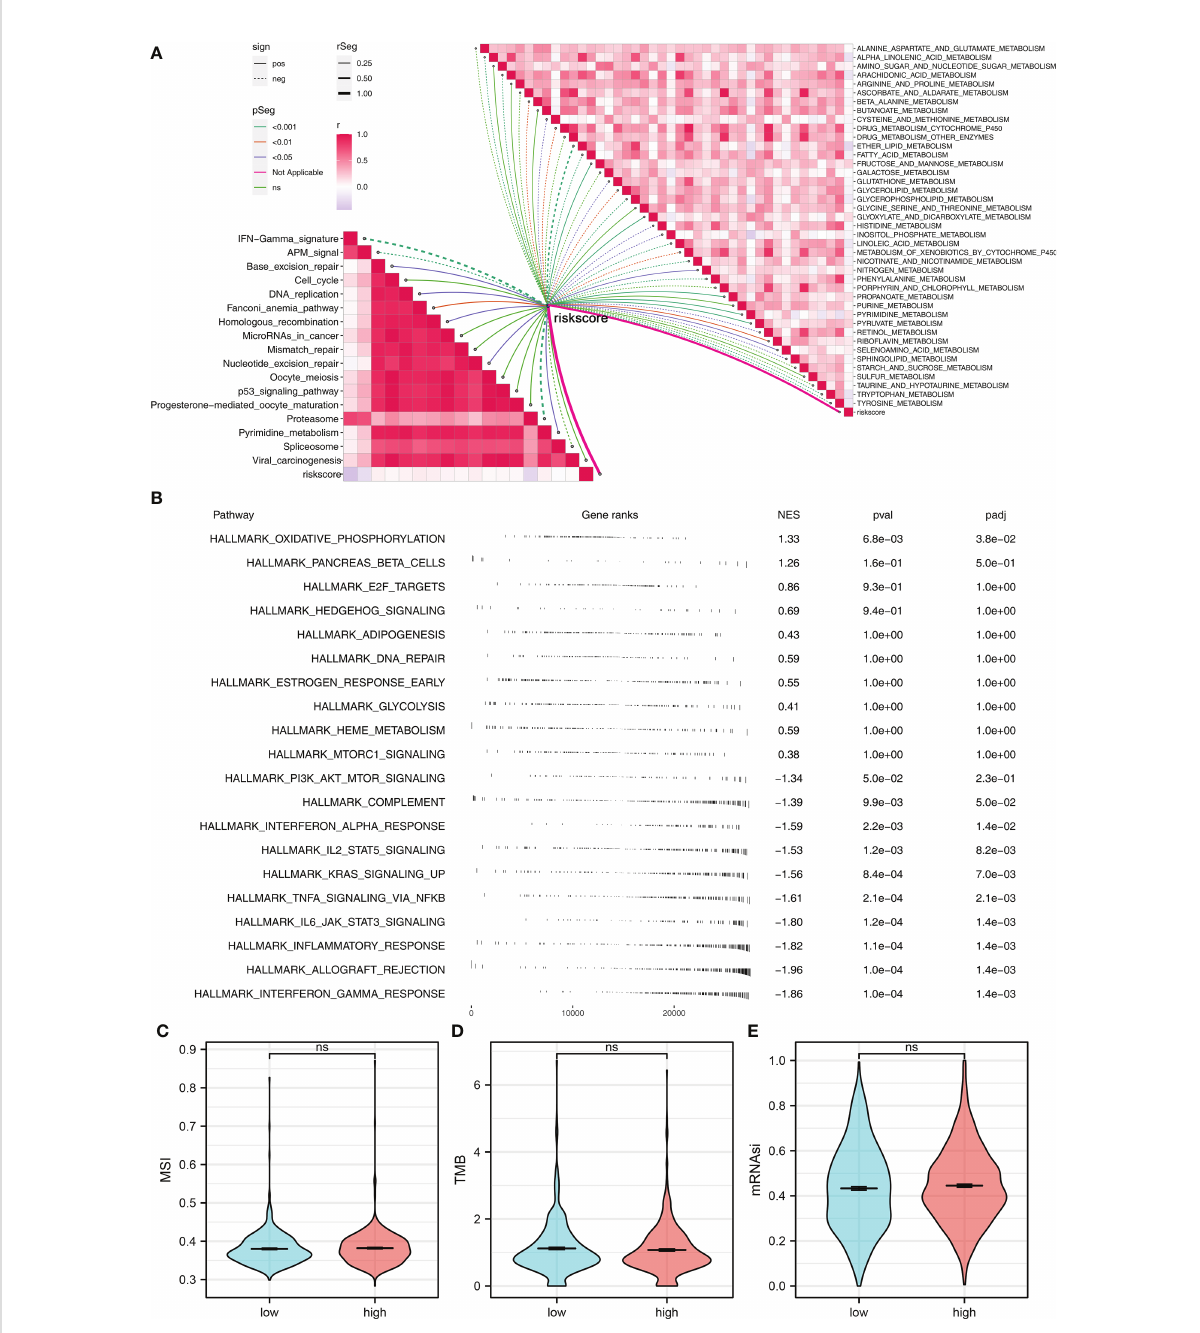
FIGURE 5 Pathway enrichment analysis (A) ssGSEA was performed to evaluate the correlation between riskscore and immune and metabolism pathways. (B) GSEA was performed to explore the underlying biological differences between high- and low-risk groups. (C – E) The TMB, MSI, and mRNAsi differences between high- and low-risk patients. ns P >